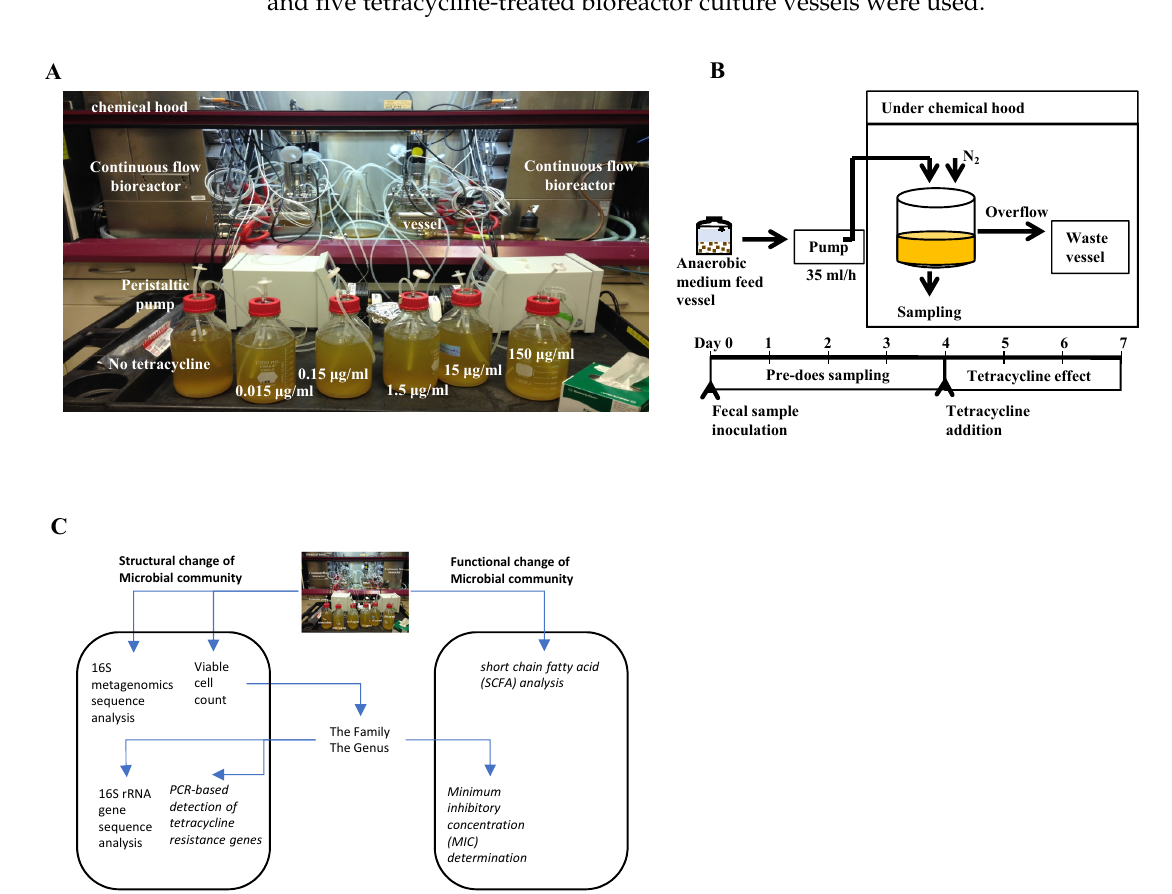
Figure 1. A laboratory continuous flow bioreactor (six reactors with 0, 0.015, 0.15, 1.5, 15, and 150 µ g/mL tetracycline) ( A ); a schematic diagram and timeline ( B ); overview of measuring effects of tetracycline on human intestinal microbiota ( C